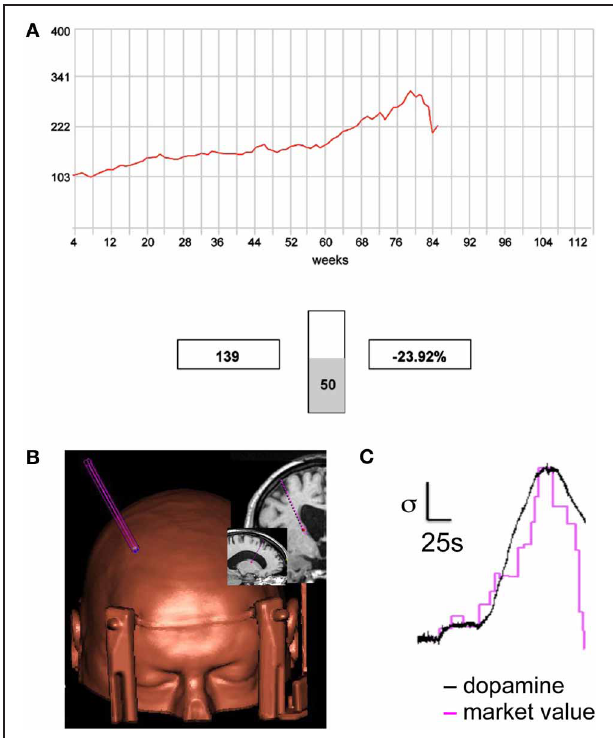
FIGURE 2 | Sub-second dopamine release during the sequential investment task. (A) Screen shot from the sequential investment task (Lohrenz et al., 2007; Chiu et al., 2008; Kishida et al., 2011). Participants are provided (1) a trace of the market, (2) the value of their portfolio (shown in this screen shot: “$139”), and (3) the fractional change in the value of their portfolio following their most recent investment decision (shown: “ − 23.92%”). Participants lodge investment decisions using button boxes that control a visually displayed vertical slider bar. (B,C) Fast-scan cyclic voltammetry on a carbon fiber microsensor was used to track dopamine release in the caudate of a human patient performing the sequential investment task. (B) A reconstructed image showing the microsensor trajectory and the depth target in the caudate (see MRI image insets). (C) Measurements of extracellular dopamine track the market value. Magenta trace: market value as the participant lodges investments (20 decisions shown); Black trace: measured dopamine release in the patient’s caudate sampled at 10Hz. Scale bars (normalized units): vertical bar indicates one standard deviation; horizontal bar indicates 25s (Kishida et al.,